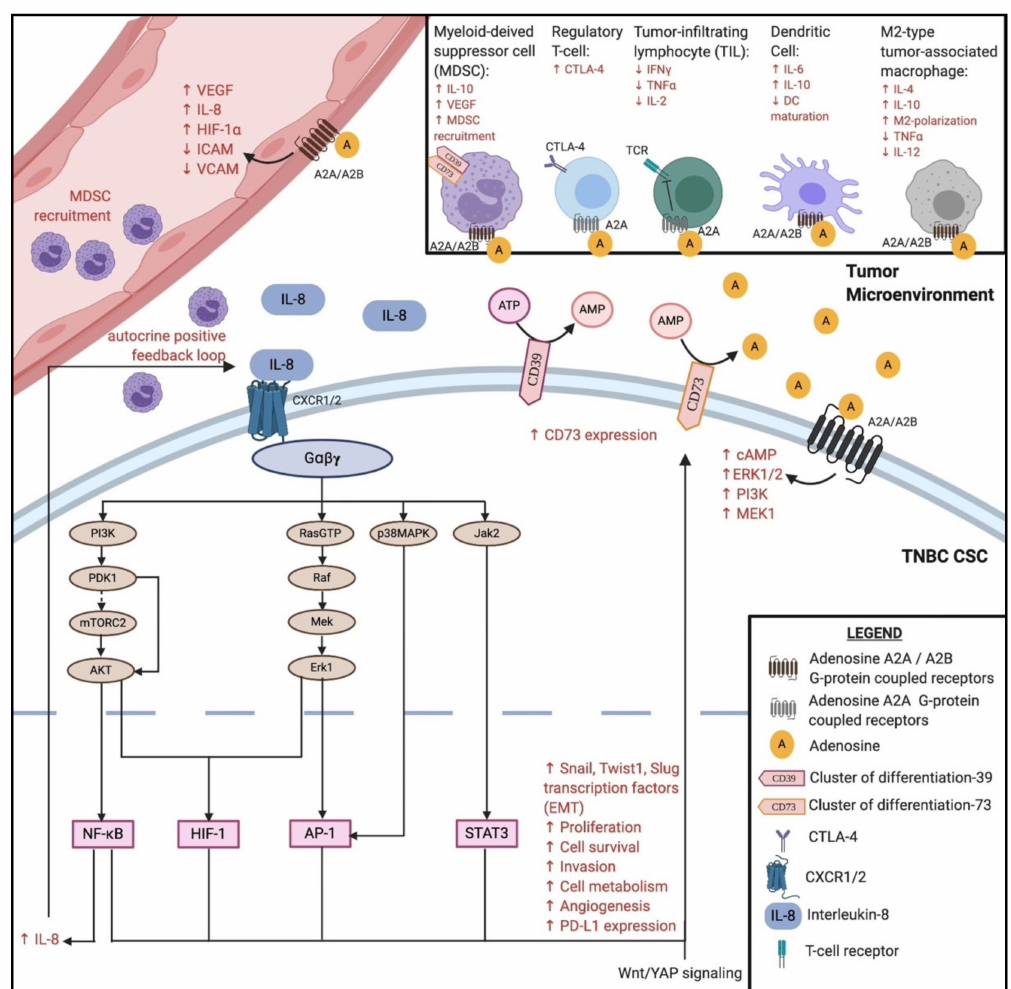
Figure 2. Various tumor-promoting mechanisms that can be exploited in combination with immune checkpoint inhibition. Overexpression of IL-8 and CXCR1 / 2 in TNBC generates an autocrine positive feedback loop that promotes EMT, HIF-1-mediated angiogenesis and endothelial migration, and recruitment of immunosuppressive MDSCs to the tumor microenvironment (TME). Transcription of NF- κ B, HIF-1, AP-1, and STAT3, in combination with Wnt and YAP signaling, upregulates CD73 on TNBC cells. Immunogenic cell death in the TME releases ATP in abundance, which is subsequently converted to adenosine by CD39 and CD73. Excess adenosine in the TME bind to adenosine type 1 purinergic G-protein coupled receptors that further facilitate MDSC expansion, CTLA-4 upregulation, inhibition of TIL activation, inhibition of DC maturation, and M2-type TAM polarization. Activation of adenosine receptors on tumor-associated endothelial cells promotes angiogenesis via upregulation of VEGF and HIF-1 α , along with a simultaneous downregulation of adhesion molecules essential for diapedesis. Finally, activation of adenosine receptors on the TNBC cell further upregulate cytosolic cyclic AMP (cAMP), Erk1 / 2, PI3K, and MEK1, all of which further enhance the IL-8 signaling pathway. Figure created with